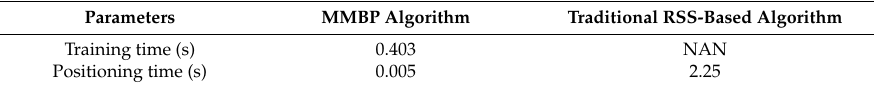
Figure 16. MSE performance with the arbitrary training data set. Table 5. Time cost of di ff erent algorithms with arbitrary training data set. Table 5. Time cost of different algorithms with arbitrary training data set.